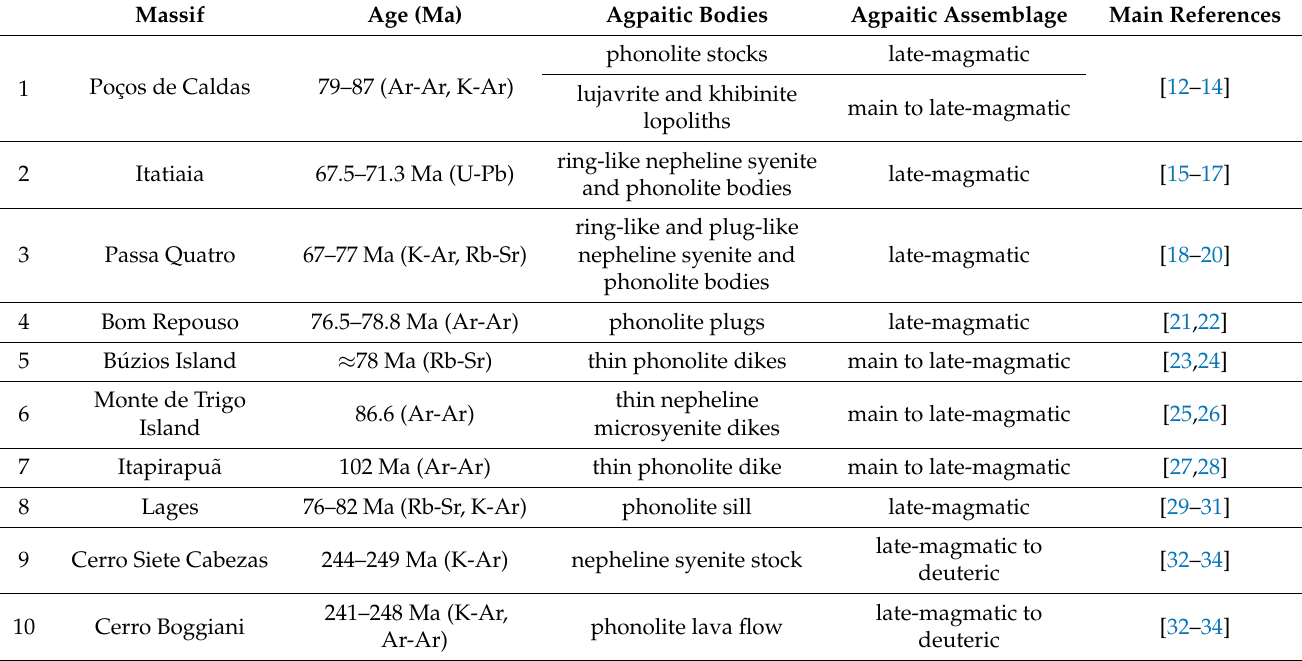
Table 1. General information on agpaitic